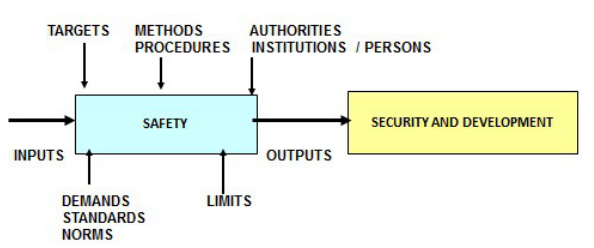
Figure 2. Process model for formation of safety of entity under account [1] [5].